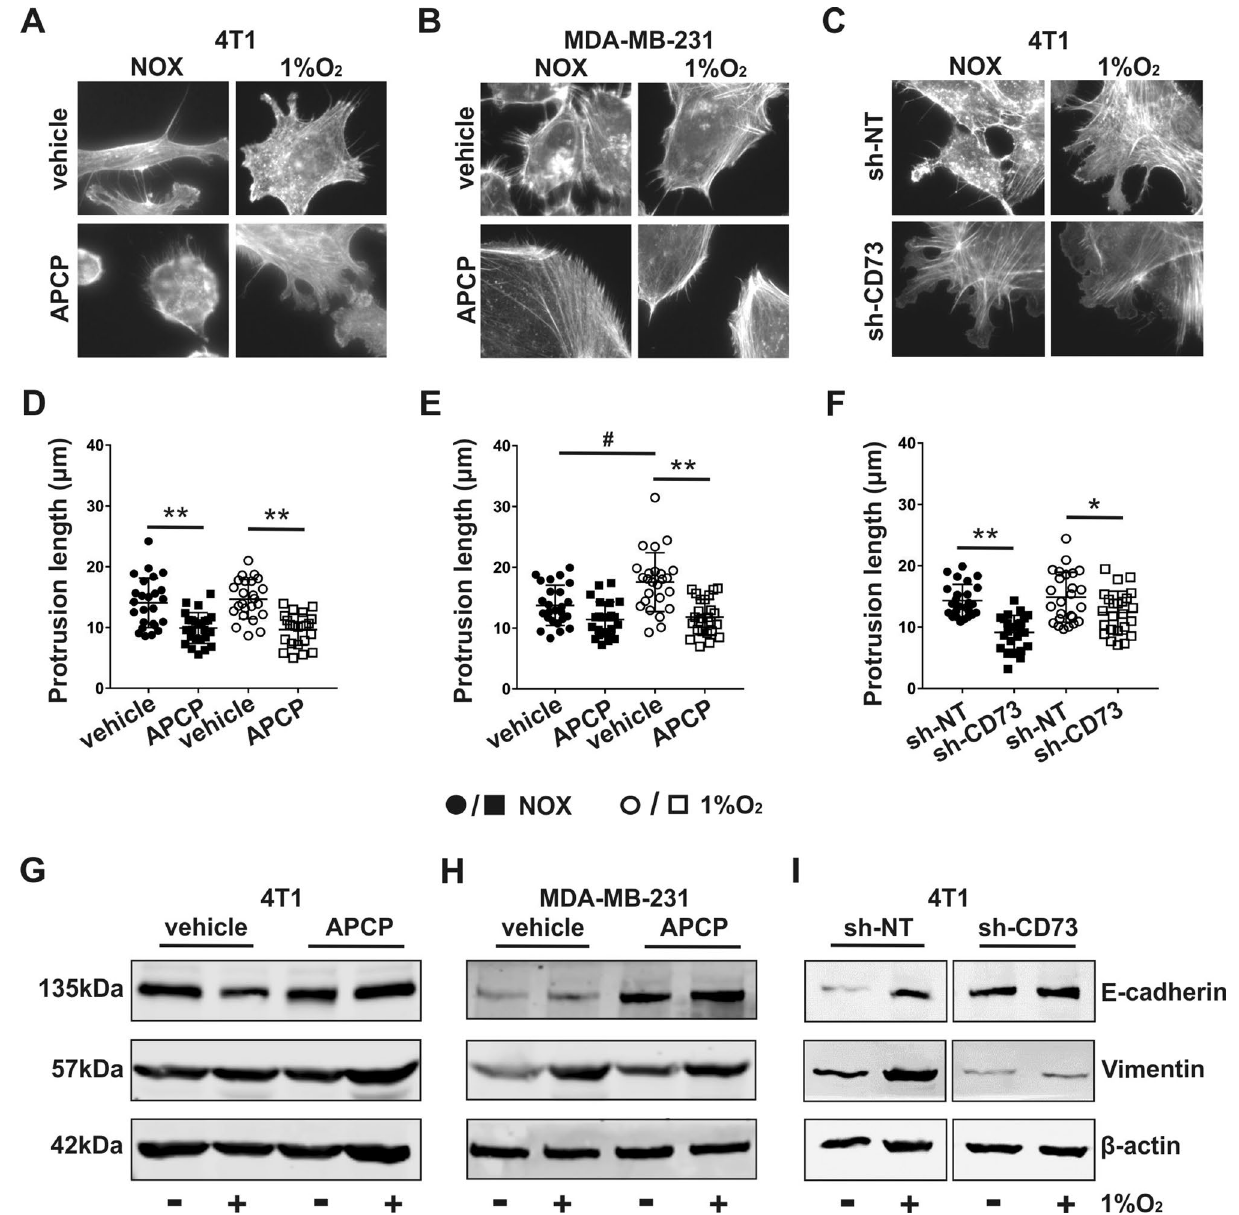
Figure 4. Suppression of CD73 inhibits EMT. Representative images of F-actin immunostaining from ( A ) APCP-treated 4T1 cells, ( B ) MDA-MB-231 cells and ( C ) sh-NT and sh-CD73 4T1 cells in normoxia and 1% O 2 . Quantification of protrusion lengths of ( D ) APCP-treated 4T1 cells and ( E ) MDA-MB-231 cells and ( F ) sh-NT and sh-CD73 4T1 cells, in normoxia and 1% O 2 . The results are expressed as mean ± SD from 3 independent experiments, n = 25 cells analyzed in each group. E-cadherin and vimentin protein expressions in ( G ) APCP- or vehicle-treated 4T1 cells, ( H ) APCP- or vehicle-treated MDA-MB-231 cells and ( I ) sh-NT and sh-CD73 4T1 cells. The blots were taken from different parts of the same gel. The results are expressed as mean ± SD, n = 3. *P < 0.05 and **P < 0.001 vs representative controls, by a two-tailed Student’s t-test; # P < 0.05; vehicle- vs. APCP- treated cells under 1% O 2